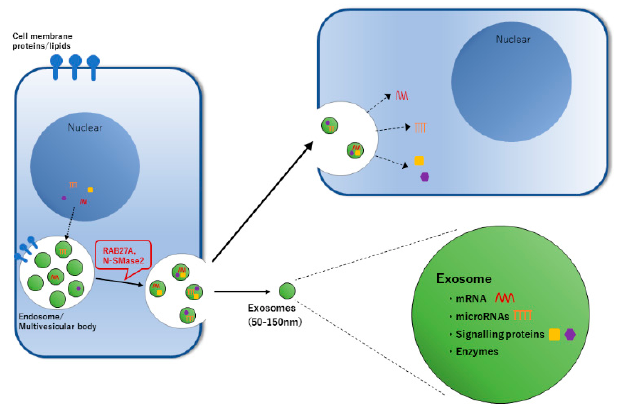
Figure 1. Exosomes can transfer information via cell-to-cell communications. Exosomes (EXs) are membrane vesicles secreted from many kinds of cells. EXs contain various secretory cell-derived proteins and RNA, including endosome-derived proteins, proteins involved in intracellular transport and cell membrane-derived proteins. In addition, they contain lipids derived from the cell membrane of endocrine cells and endosomal membranes. EXs taken up by the target cells fuse with their endosomal membrane to release the contained RNAs into the cytoplasm of the target cells. A released mRNA is translated into a protein, whereas the miRNAs suppress the translation of the target gene and thus EXs control the gene expression in the target cell. In addition, these EXs components are different from those in EX secretory cells. Therefore, a specific mechanism by which EX proteins and mRNA/miRNA are selectively loaded into EXs was suggested.